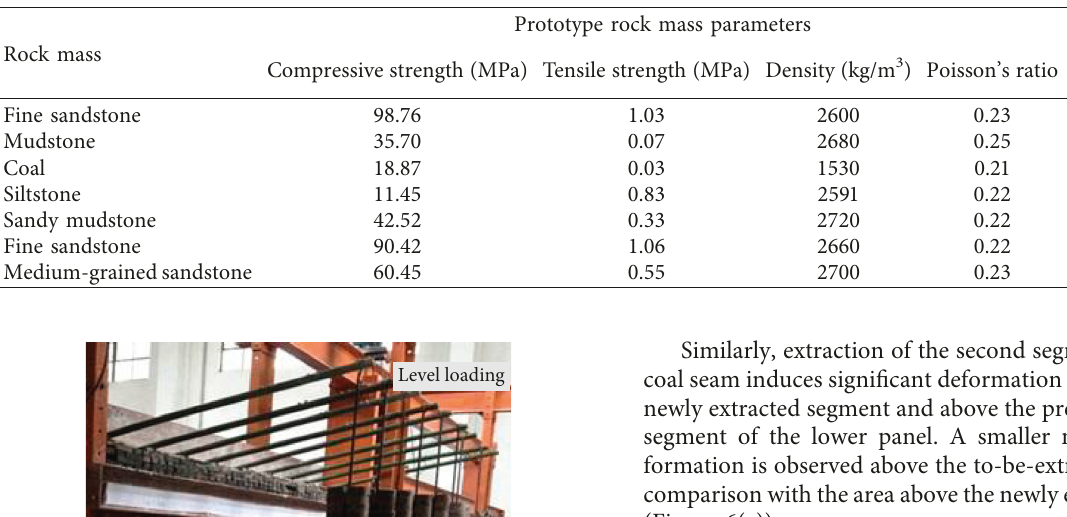
Table 4: Prototype material properties and mixture proportions of the construction material.